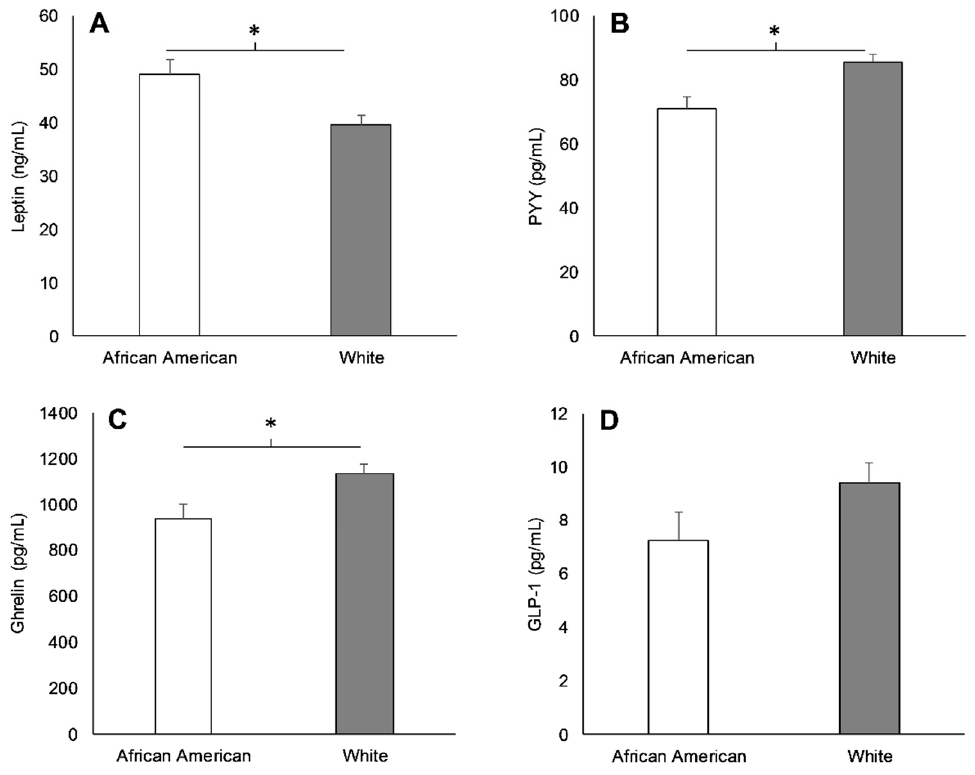
Figure 1. Leptin ( A ), peptide YY (PYY) ( B ), ghrelin ( C ), and glucagon-like peptide-1 (GLP-1) ( D ) in African Americans (AAs) and Whites before lunch during the baseline visit. * Significant difference between races ( p < 0.05). Values are means ± standard error of the mean (SEM).